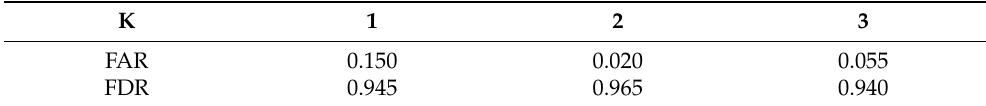
Table 2. FDALM monitoring results for different K